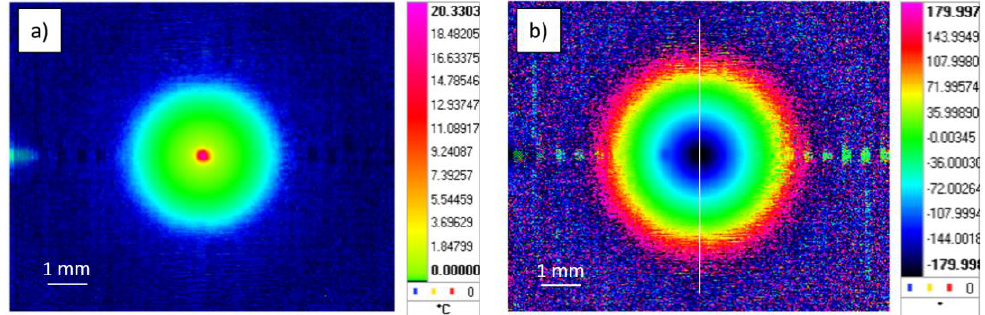
Figure 5. ( a ) Amplitude and ( b ) phase thermograms of Sample 1 at the surface 0 mm from the substrate, with a modulation frequency of 7 Hz. The white vertical line corresponds to the phase profile used for thermal diffusivity measurements. The scale of the amplitude is in °C and the phase is in degrees.